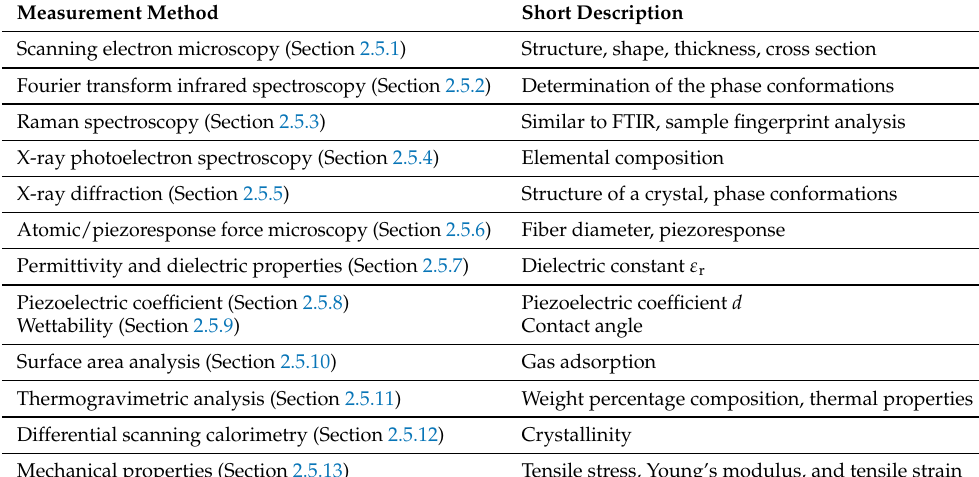
Table 3. The most used methods for the study of PVDF nanogenerators.